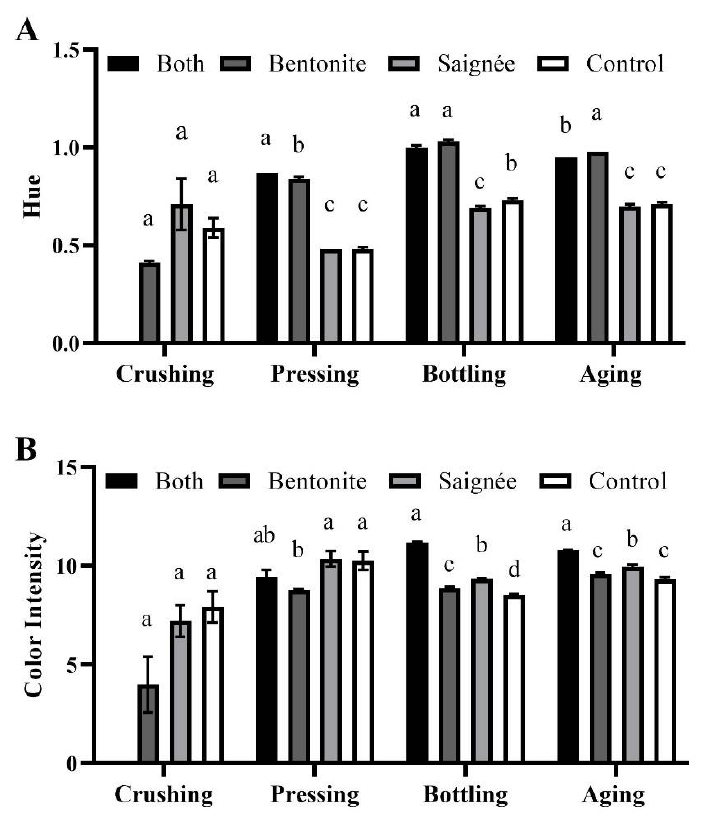
Figure 1. Color characteristics in Marquette grape musts and red wines throughout the winemaking process: ( A ) Hue and ( B ) Color intensity. The error bars represent standard deviation of the mean ( n = 2). Lowercase letters indicate significant difference ( p -value < 0.05) among treatments within same time point. “Both” means saignée plus bentonite treatment. There was no “both” treated sample collected at crushing.